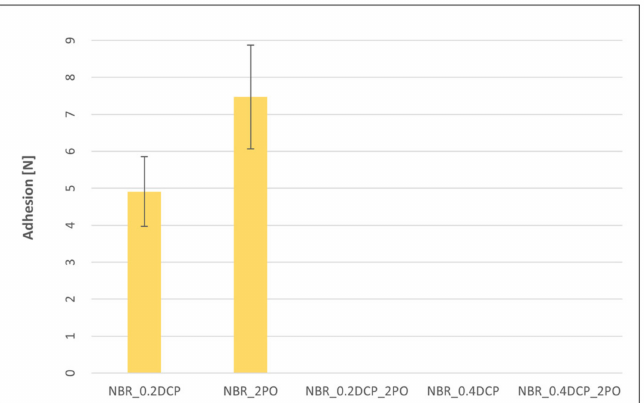
Figure 15. Influence of the modified resin addition on adhesion between peroxide NBR vulcanizates and silver wires (missing bars indicate on the lack of adhesion).